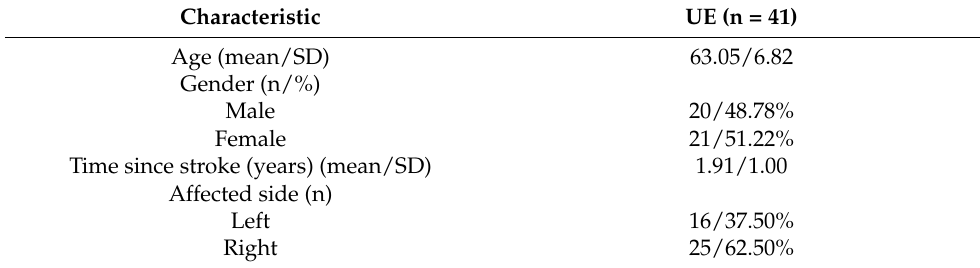
Table 2. Patient’s characteristics.